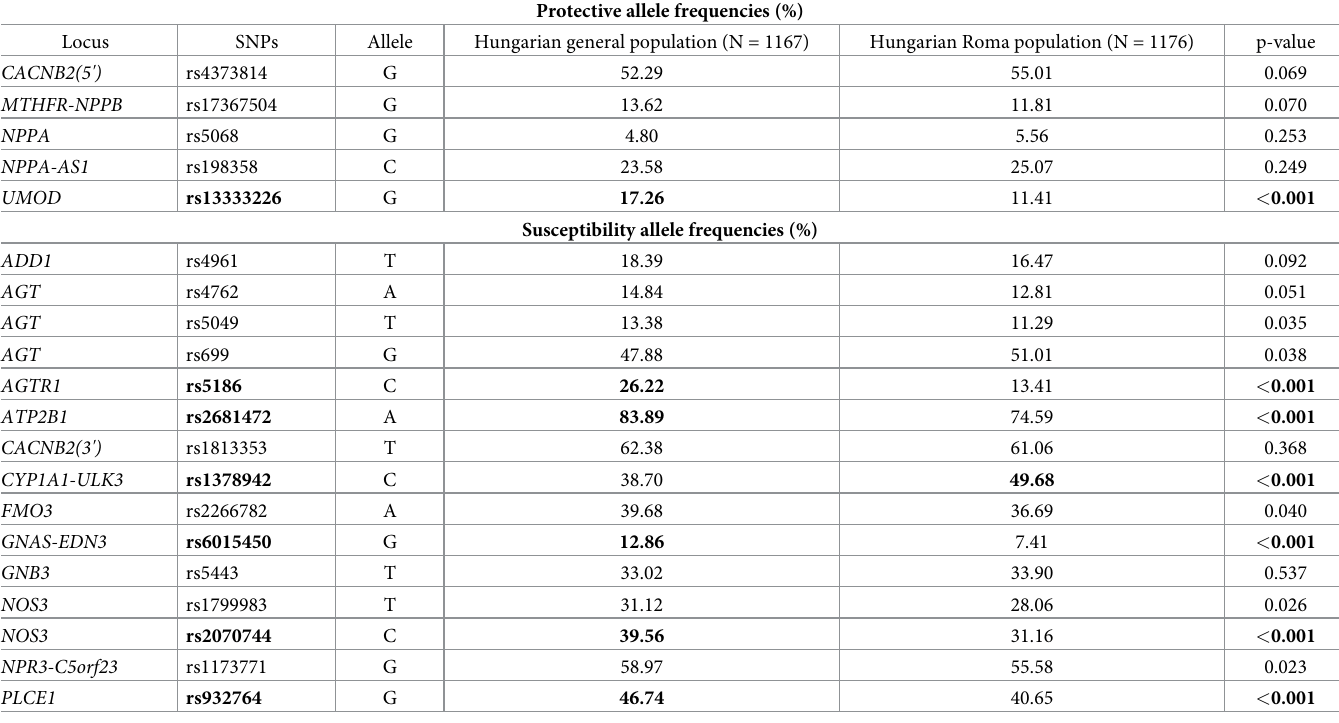
Table 2. Comparison of protective and susceptibility allele frequencies between the Hungarian general and Roma populations. Protective allele frequencies